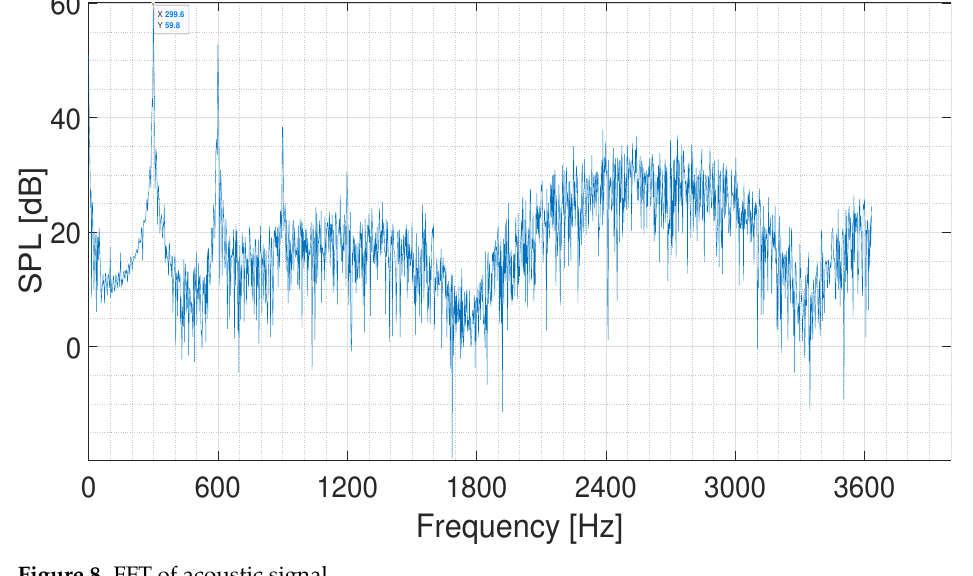
Figure 8. FFT of acoustic signal. Table 4. SWL